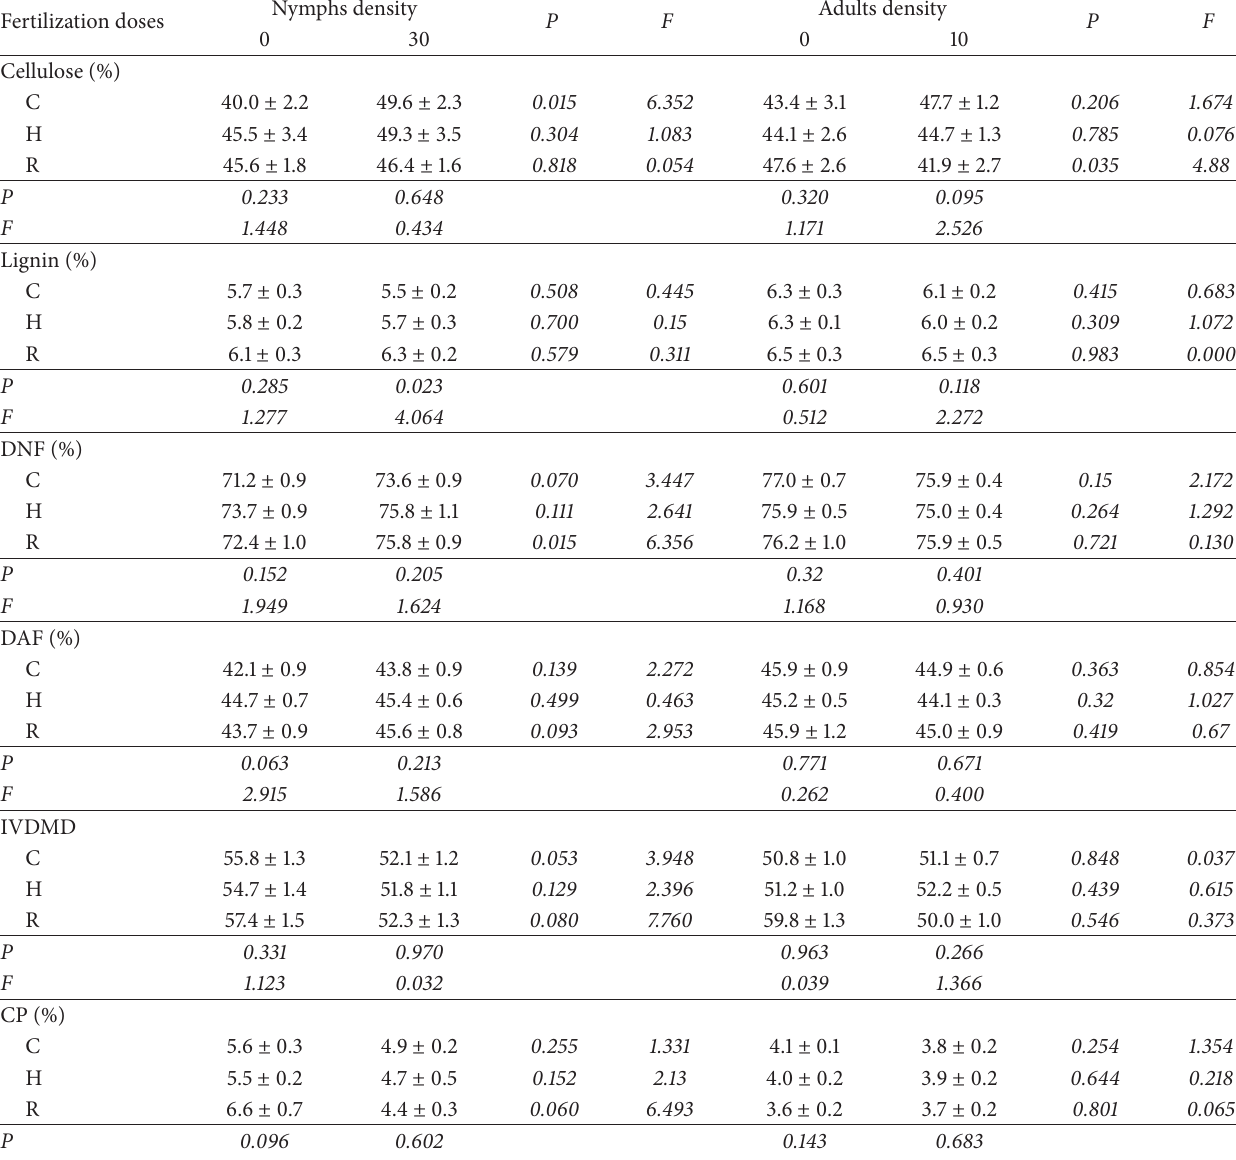
Table 2: Cellulose, lignin, neutral detergent fiber (NDF), acid detergent fiber (ADF), in vitro dry matter digestibility (IVDMD), and crude protein (CP) contents in Brachiaria ruziziensis plants, cultivated under recommended (R), half of recommended (H), and control (C) fertilization and exposed to different Mahanarva spectabilis